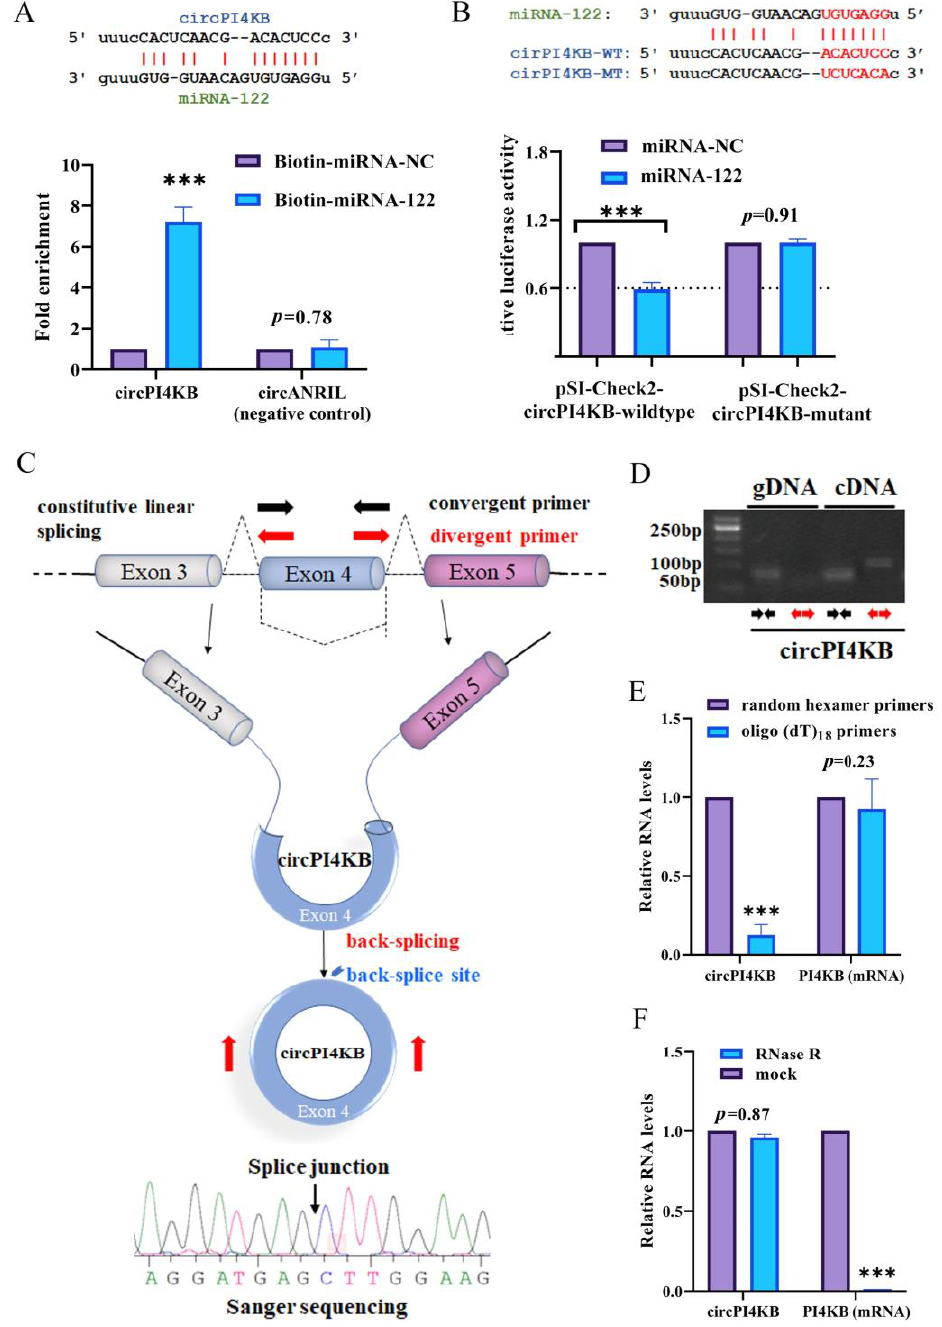
Figure 3. The validation of binding of circPI4KB and miRNA-122 and the circular structure of PI4KB. ( A ) RT-qPCR showed the level of circPI4KB in the streptavidin-captured fractions from the L02 cell lysates after transfection with 3 (cid:48) -end biotinylated miRNA-122 or biotinylated miRNA-NC, while circANRIL was known to not bind to miRNA-122 as negative control, ( n = 3). ( B ) The luciferase activity of wild-type plasmid of luci-circPI4KB-wildtype (pSI-Check2-circPI4KB-wildtype) or mutation plasmid of luci-circPI4KB-mutant (pSI-Check2-circPI4KB-mutant) in L02 cells after co- transfection with miRNA-122, ( n = 3). ( C ) Scheme illustrating the PI4KB exons 4 circularizations to form circPI4KB. The specific PCR primers used to detect circPI4KB by RT-qPCR are indicated by red arrows below. The amplified product of specific divergent primers was confirmed according to the sequence of circPI4KB by sequencing. The black arrow represents head-to-tail circPI4KB splicing sites. ( D ) Convergent primers designed to amplify PI4KB mRNA, and divergent primers designed